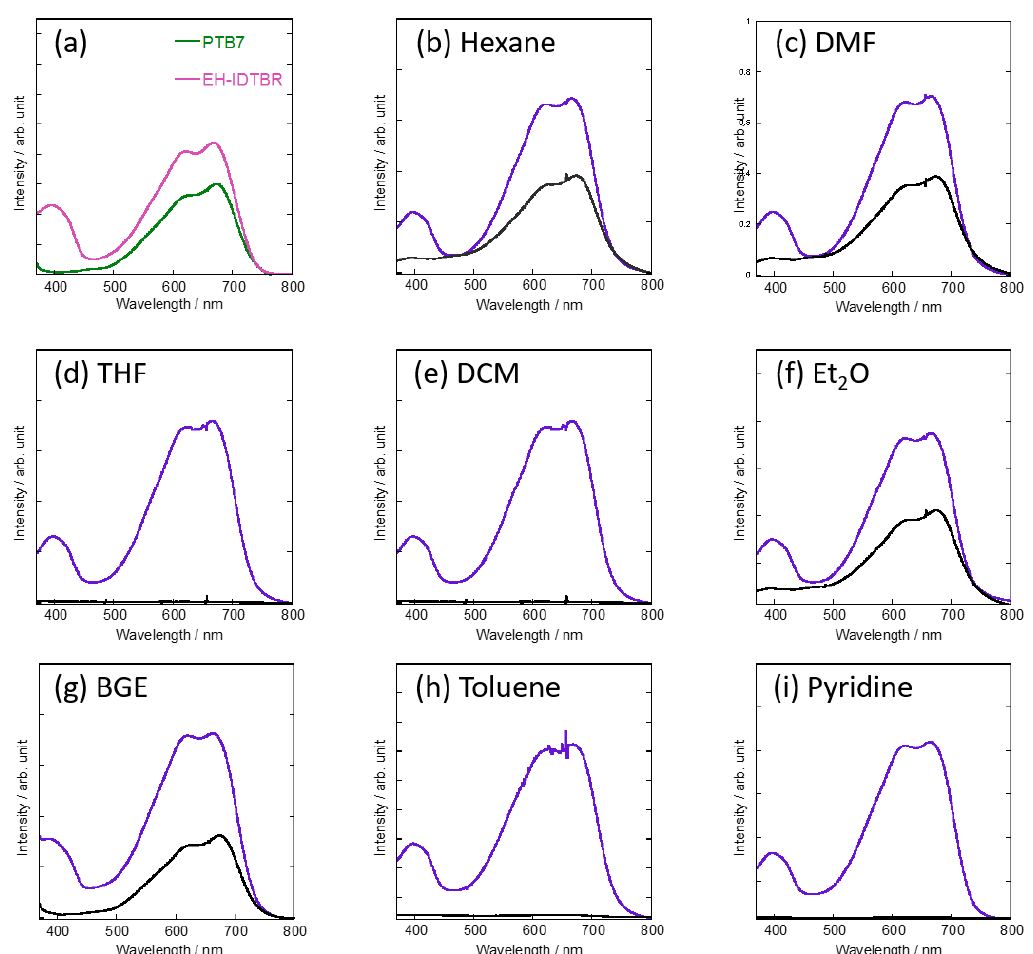
Figure 2. Absorption spectra of thin films of PTB7 and EH-IDTBR ( a ) and spectra obtained after extraction of EH-IDTBR from blend films (before: purple, after: black) using various organic solvents ( b ): n-hexane, ( c ): DMF, ( d ): THF, ( e ): DCM, ( f ): Et 2 O, ( g ): BGE, ( h ): toluene, ( i ): pyridine).